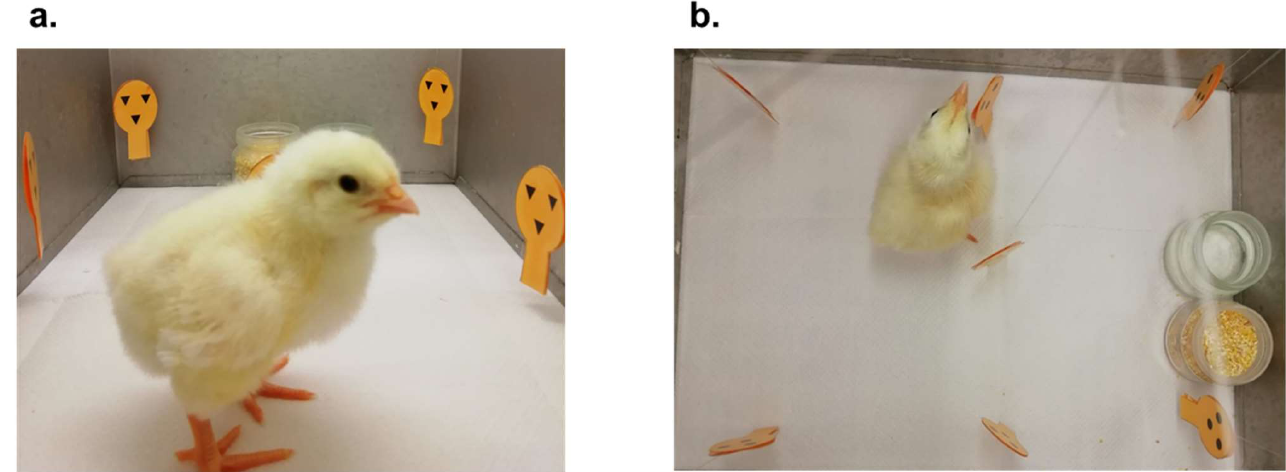
Figure 2. Rearing conditions. Each chick is reared singly with food, water, and seven bi-dimensional stimuli hung within the cage. In this figure, stimuli are all identical faces (rearing conditions of Exp. 2, and Exp. 3). ( a ) A chick’s perspective of the stimuli; ( b ) layout of the stimuli in the rearing cage, viewed from